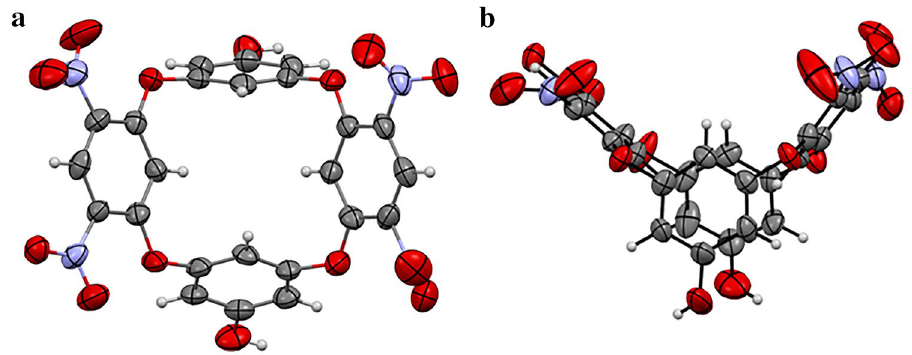
Figure 2. ORTEP of compound 1 with 50% ellipsoid probability ( a ) top view and ( b ) front